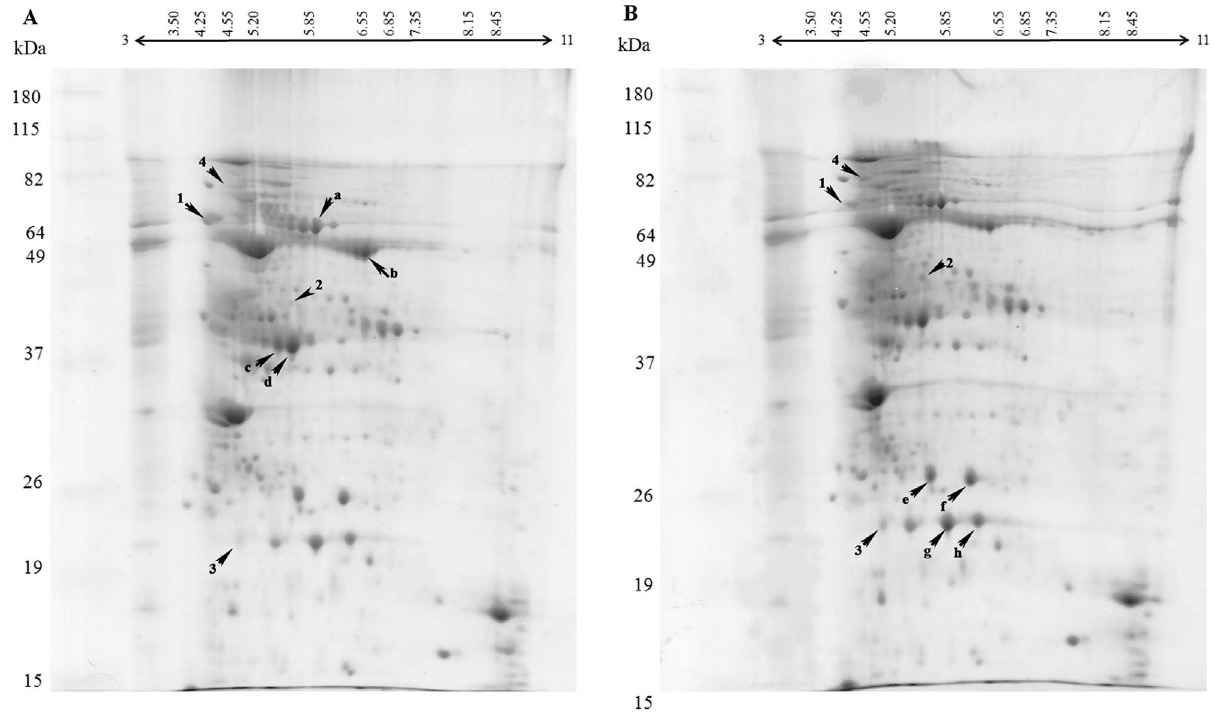
Figure 3. Two-dimensional gel electrophoresis patterns of proteins extracted from sugarcane leaves of the RB867515 cultivar watered (A) with distilled water and (B) after being subjected to 100 mM NaCl for 48 days. The strips used were 13 cm long, with a non- linear pH gradient of 3-11, stained with Coomassie G-250. The proteins indicated by numbers (1-4) correspond to those showing at least 1.5-fold difference in expression levels between the two different treatments; proteins indicated with letters (a-h) represent proteins with no difference in expression profile.